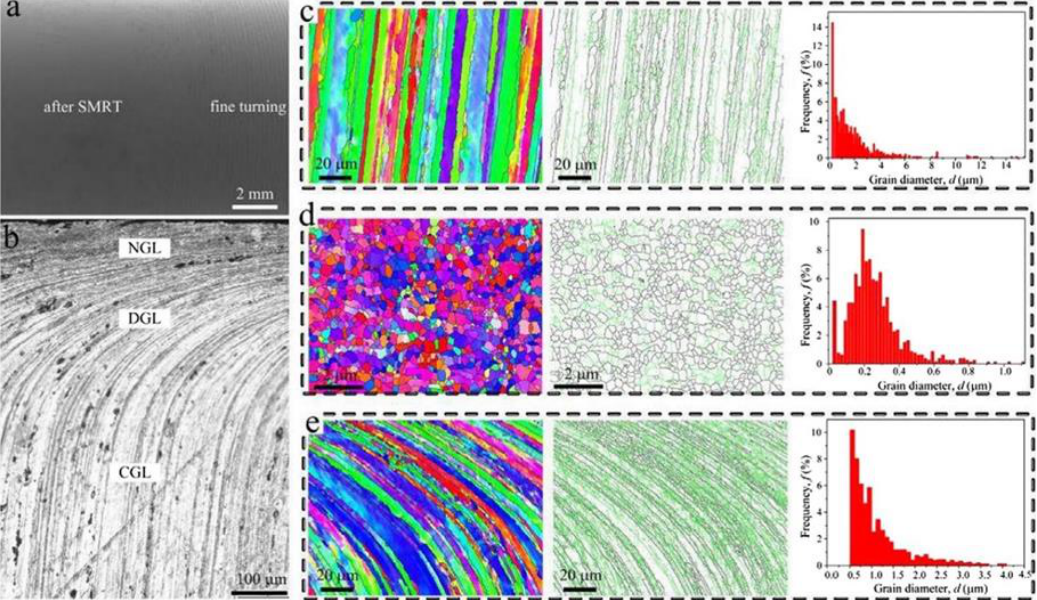
Figure 13. The surface morphology of SMRT-treated FSW 7075-T651 aluminum specimens: ( a ) surface with and without microgrooves induced by post-SMRT fine turnings; ( b ) cross-sectional microstructure of the gauge consisting of NGL, DGL, and CGL; ( c – e ) electron backscatter diffraction (EBSD) results of CGL, NGL, and DGL, respectively. Reprinted with permission from Ref. [1]. Copyright 2019 Elsevier.